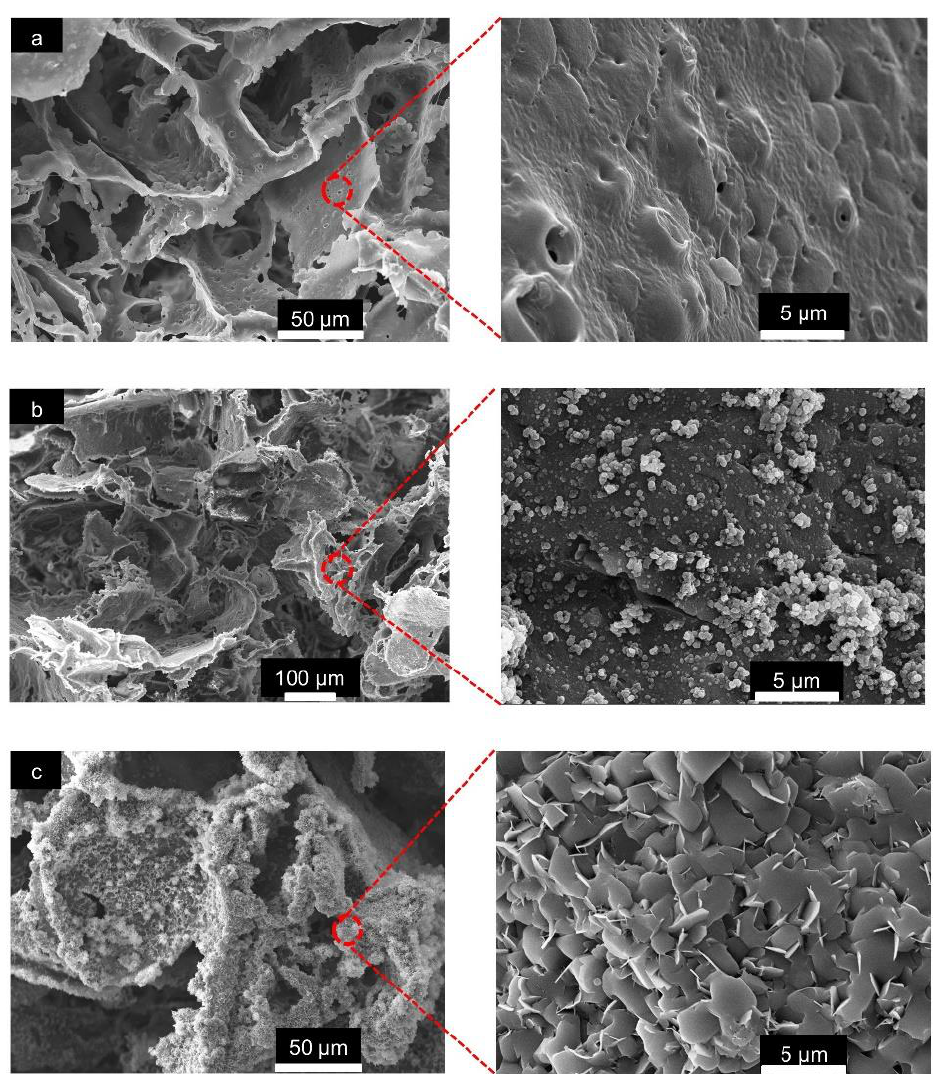
Figure 5. The SEM images of the surface of the pristine scaffold and the PLA/PBAT scaffold with PDA-assisted biomineralization at 500 × and 5000 × . The presentation of the micropores on the walls of the porous cell structures in pristine PLA/PBAT scaffold ( a ). The formation of a uniform PDA layer and some covalently bonded PDA particles and aggregates on the surface of the PDA-coated PLA/PBAT scaffold ( b ). The plate-like crystalline structure of the CaP biomineralized layer on the surface of the PLA/PBAT scaffold with PDA-assisted biomineralization ( c ). The EDX spectrum confirmed the existence of oxygen (O) and carbon (C) as the main components of the pristine PLA/PBAT scaffold (Figure 6a). The additional presence of calcium (Ca), sodium (Na), chlorine (Cl), and phosphorous (P) on the EDX spectrum of PLA/PBAT with PDA-assisted biomineralization revealed the successful formation of the CaP biomineralized layer on the outer surface of the PLA/PBAT scaffold (Figure 6b). The deposited biomineralized layer provided the Ca/P atomic ratio of